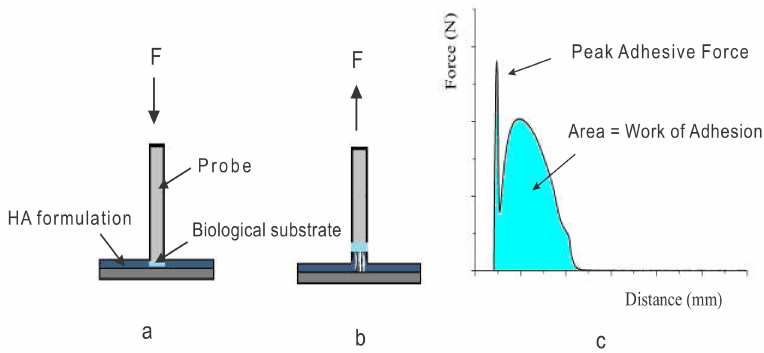
Figure 2. Scheme of a typical tack adhesion system during ( a ) contact and ( b ) separation steps. ( c ) A typical force vs. distance curve obtained from a tack measurement.